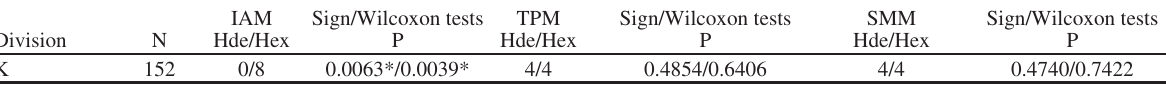
Table 4. – Results from the BOTTLENECK tests for eight microsatellite loci studied in the Epinephelus marginatus group (K) identified using STRUCTURE. Sign and Wilcoxon tests for excess heterozygosity: N, number of individuals analysed; Hde, number of loci showing a heterozygosity deficiency; Hex, number of loci showing excess heterozygosity. IAM, Infinite-Allele Model; TPM, Two-Phase Model (90% SSM), SMM, Stepwise-Mutation Model, * significant values under the sign/Wilcoxon test (P ≤